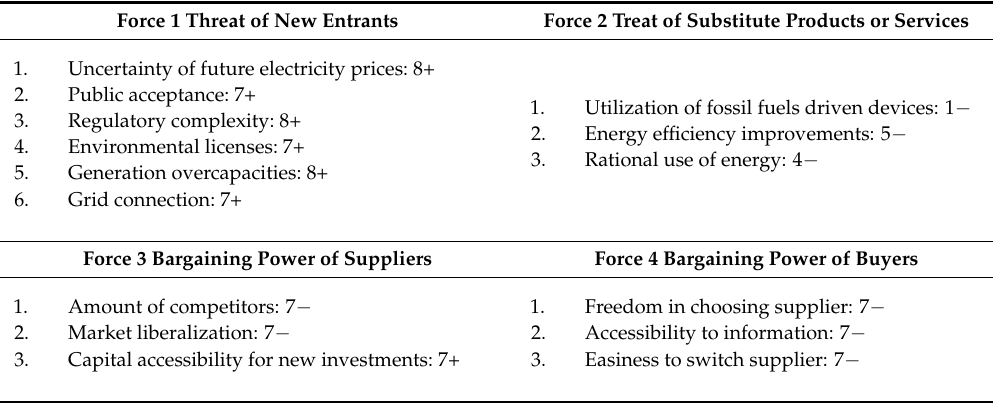
Table 1. Porter’s five forces analysis factors with respective importance and influence concerning the electricity market price in the European Union.